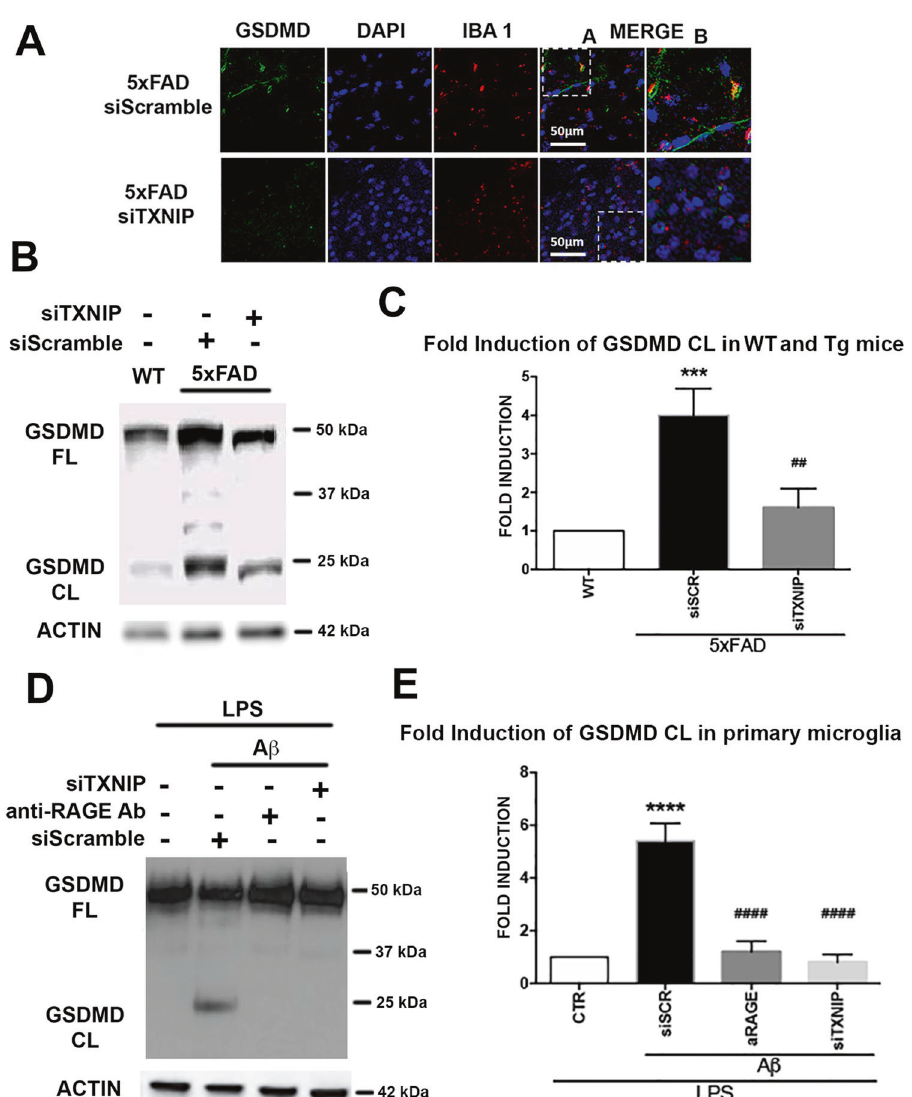
Fig. 6 TXNIP silencing prevents GSDMD cleavage in vitro microglia and in vivo 5xFAD. A IHC analysis of GSDMDC1 (green) and Iba1 (red) in 4 m old control and 5xFAD mice hippocampus treated as indicated ( n = 4). B , C Western blot of native gel ( B ) and quanti fi cation ( C ) of GSDMD cleavage in wt and 5xFAD mice hippocampus treated as indicated. Total GSDMD and actin were used to normalize. One-way ANOVA followed by Tukey ’ s multiple comparison test ( n = 3; *** p < 0.001 versus control; ## p < 0.01 versus siScramble). D , E Western blot of native gel ( D ) and quanti fi cation ( E ) of GSDMD cleavage in LPS-primed primary microglia treated as indicated. Total GSDMD and actin were used to normalize. One-way ANOVA followed by Tukey ’ s multiple comparison test ( n = 3; **** p < 0.0001 versus control; #### p < 0.0001 versus